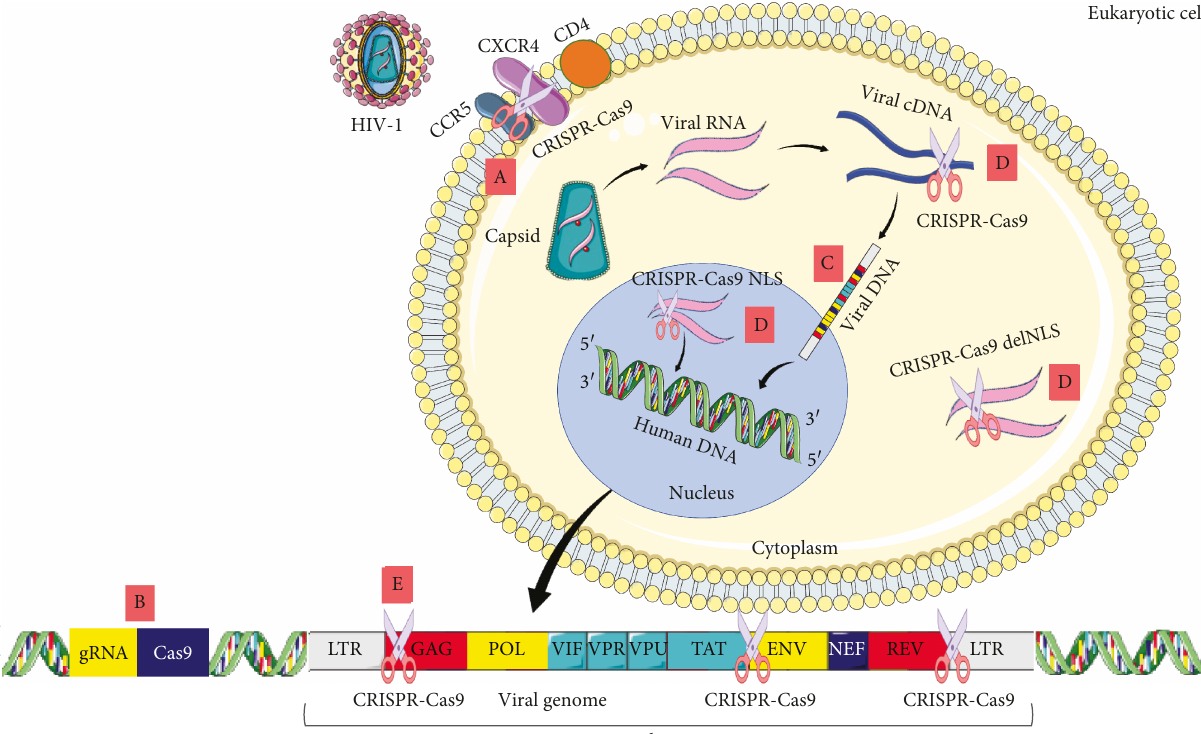
Figure 1: Overview of the CRISPR-Cas strategy to interfere on the HIV-1 infection cycle. A: use of the CRISPR-Cas system to introduce loss- of-function mutations in the CCR5 and/or CXCR4 coreceptors in several cell types; B: inhibition of virus-cell invasion, reverse transcription, and integration by Cas and gRNA stable expression from the host cell genome; C: inhibition of viral replication through targeting gRNAs to di ff erent sites in the HIV-1 genome, including LTR, gag , pol , tat , and rev ; D: inactivation of viral genetic material prior to integration into host DNA by transductions with Cas9-NLS or Cas9-delNLS and gRNA, whose targets are the R and U5 regions of LTR; E: rupture of the proviral genome from latent reservoirs with the LTR region as the main target, or by targeting other viral genes, thus modulating several HIV-1 characteristics and its infectious